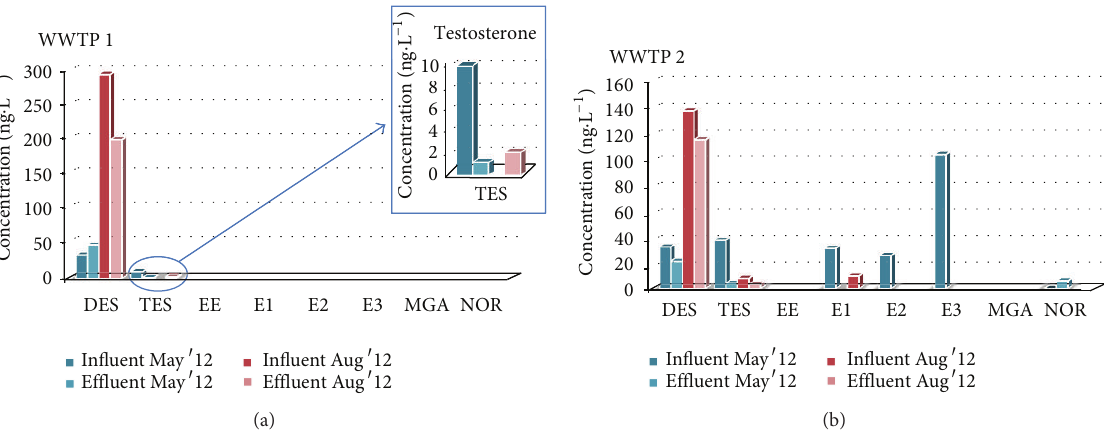
Figure 4: Concentrations of target compounds in sewage samples from both wastewater treatment plants (WWTPs). Table 3: Analytical parameters for the SPE-UHPLC-MS/MS